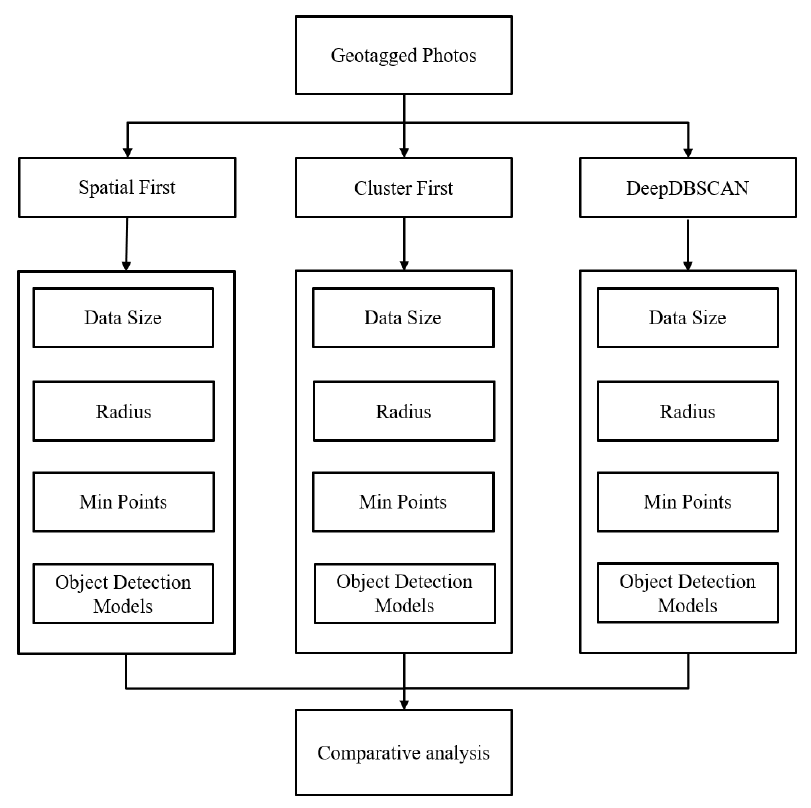
Figure 6. Experimental